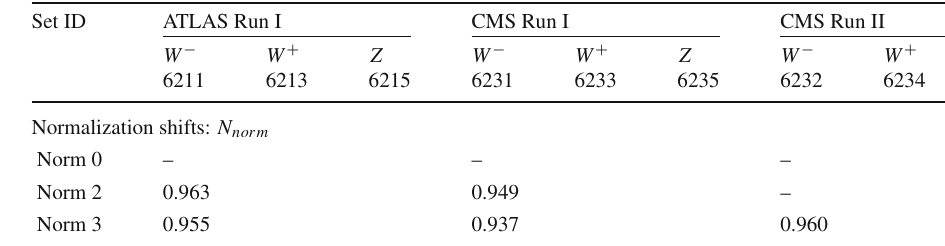
Table 2 The LHC W ± / Z